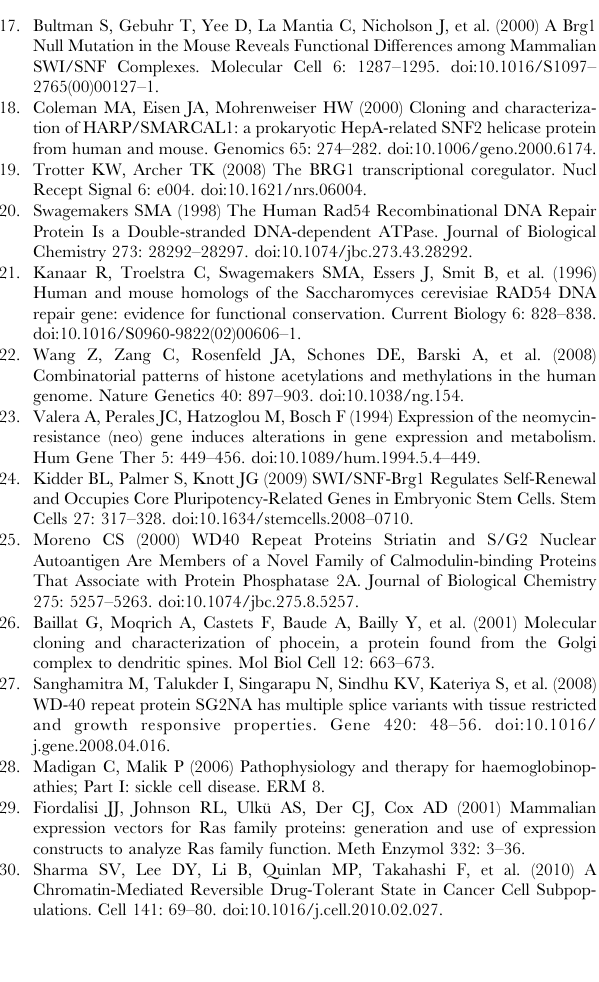
Table S3 P-values calculated for RT-PCR data showing alteration in expression of ADH4, Nanog, RUNX2, EP400 and